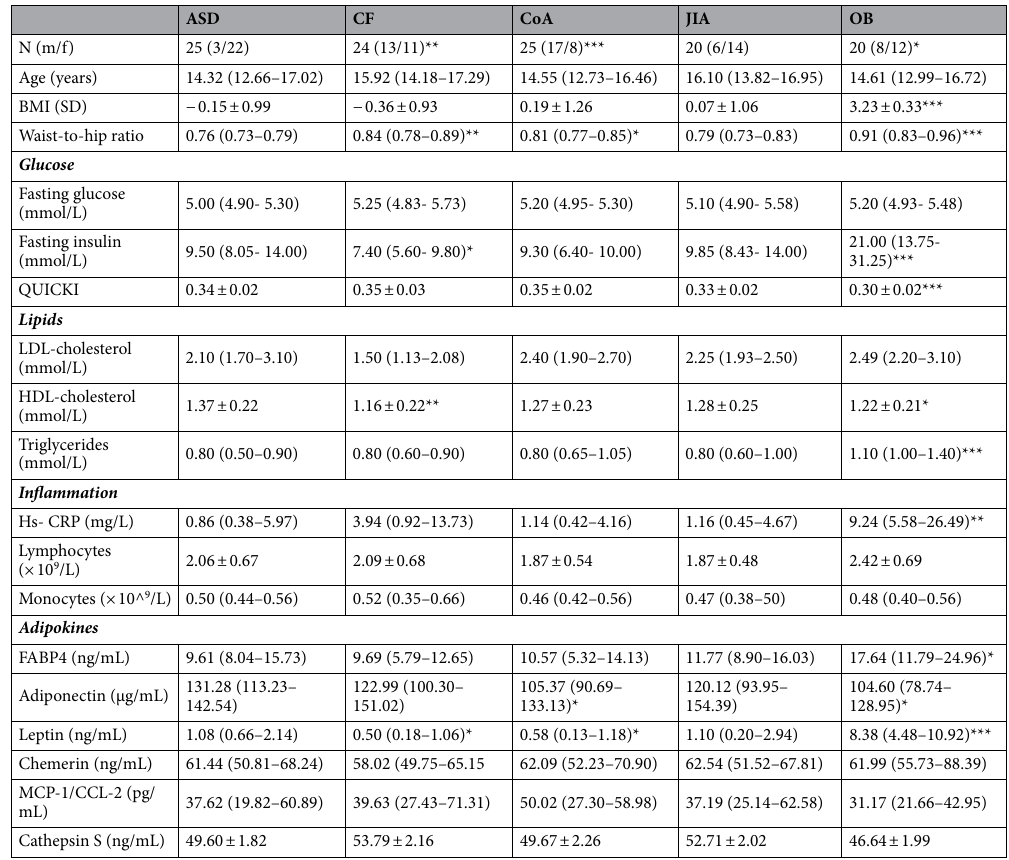
Table 1. Immunometabolic profiles of adolescents with chronic disease. ASD: atrial septal defect, CF: cystic fibrosis, CoA: coarctation of the aorta, JIA: juvenile idiopathic arthritis, OB: obesity, BMI (SD): body mass index standard deviation from the age- and sex matched population mean, QUICKI: quantitative insulin sensitivity check index, LDL: low-density-lipoprotein cholesterol, HDL: high-density-lipoprotein cholesterol, hs-CRP: high sensitivity C-reactive protein, FABP4: fatty acid binding protein 4, MCP-1: monocyte chemoattractant protein 1, CCL-2: C–C motif chemokine ligand 2. All chronic disease groups were compared to healthy ASD controls. * p < 0.05, ** p < 0.01, *** p <